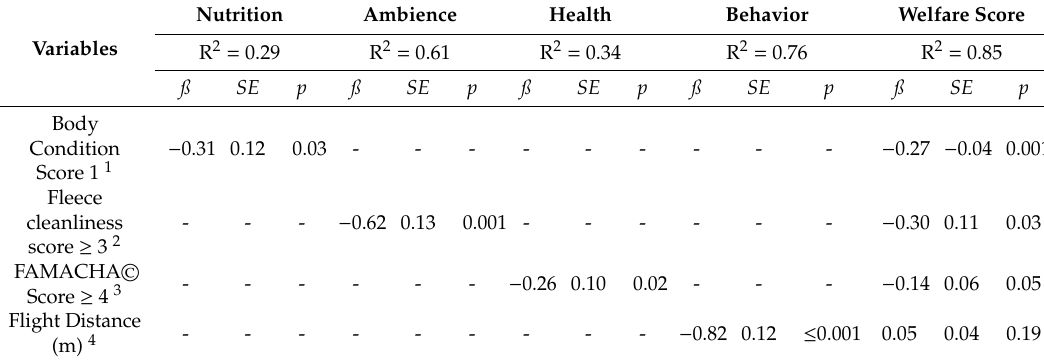
Table 4. Bivariate linear regression models showing animal-based indicators significant for Nutrition, Ambience, Health and Behavior domains, and a multivariable model evaluating factors associated with the overall on-farm welfare